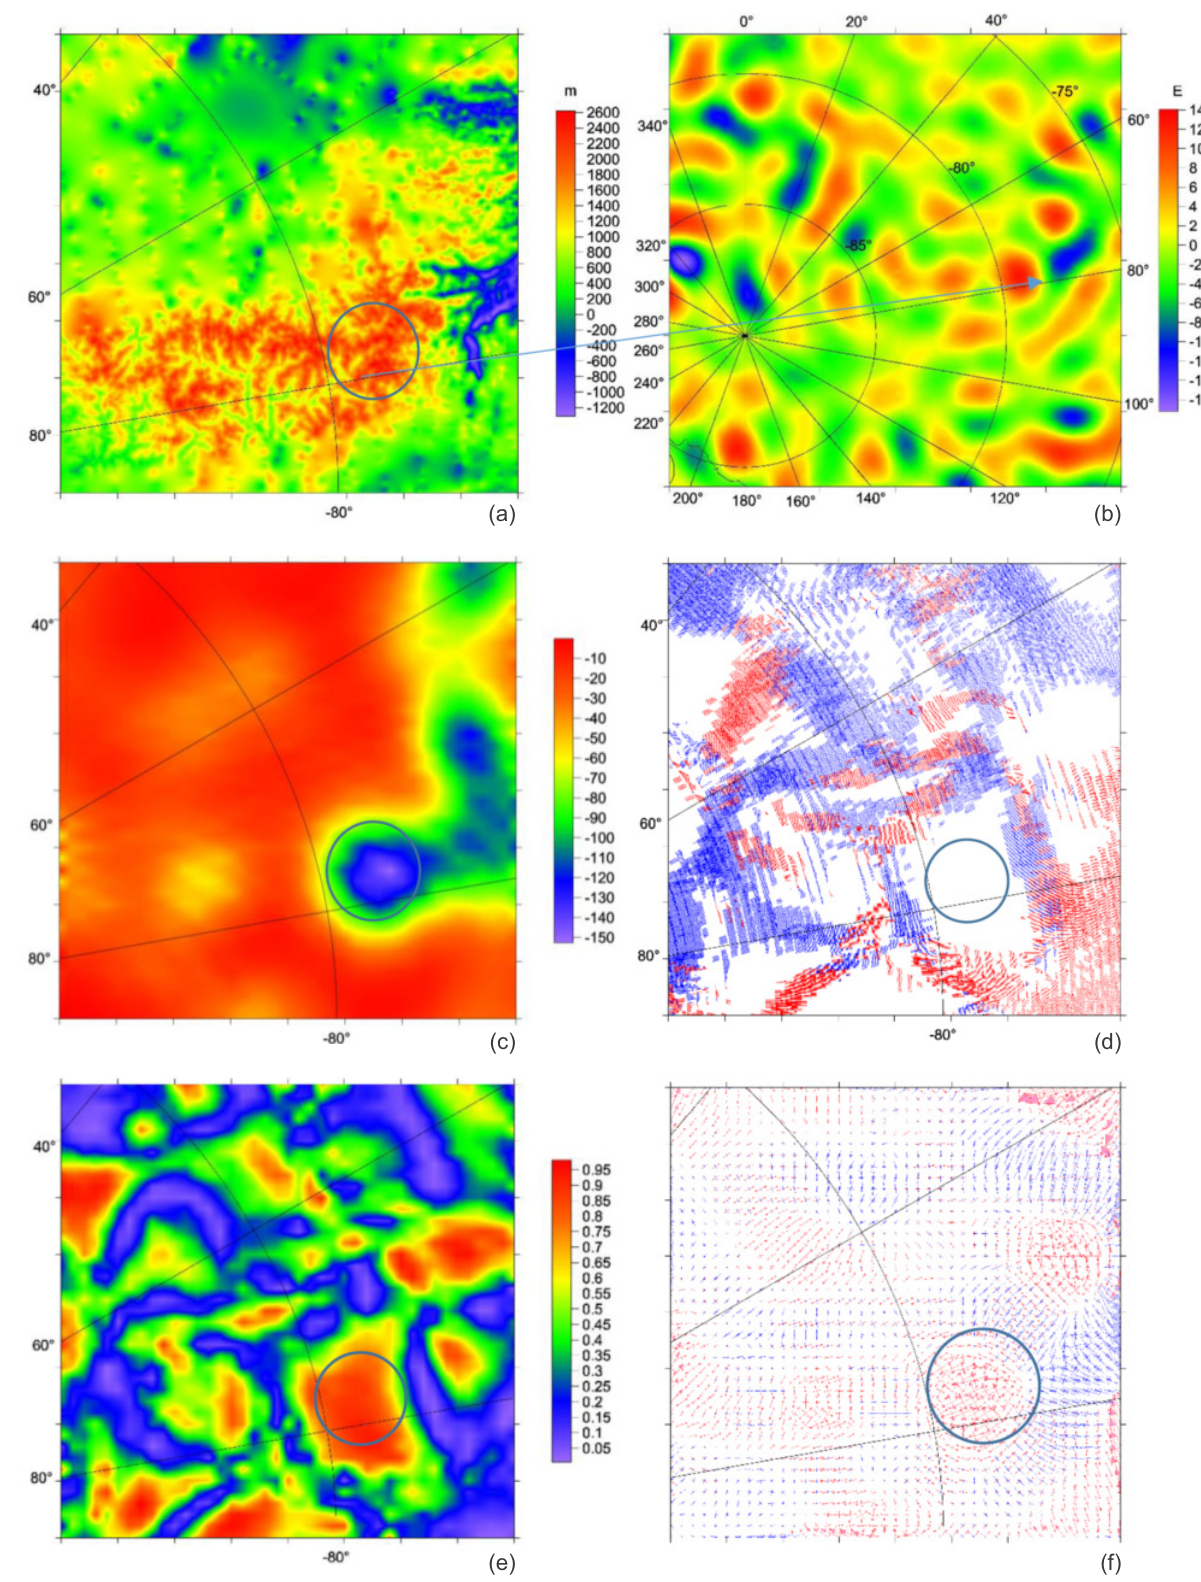
, (c) I , (d) i (for I < 0.3), (e) the ratio I , and (f) vd zz 1